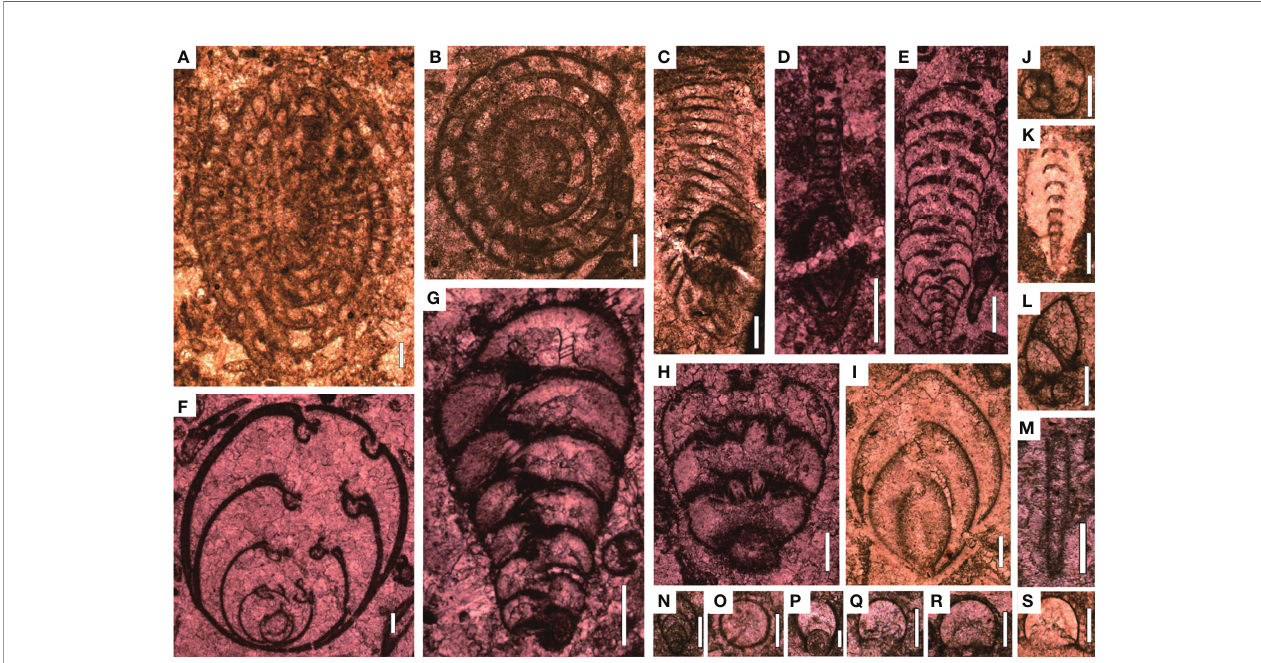
FIGURE 5 | Foraminifers from Bed 1 of the Chongyang section before the PTME. (A) Nankinella orientalis; (B) Sphaerulina crassispira; (C) Reichelina purlchra; (D) Reichelina media; (E) Climacannina spathulata; (F) Paraglobivalvulina piyasini; (G) Palaeotextularia longiseptata; (H) Cribrogenerina prosphaerica; (I) Ichthyofrondina palmata; (J) Poatendthyrasp.; (K) Pachyphloia ovata; (L) Globivalvulina sp.; (M) Earlandia sp.; (N) Frondina permica; (O – S) Diplosphaerna inaequalis. Scale bars in panels (A – I) are 200 m m in length and in panels (J – S) are 100 m